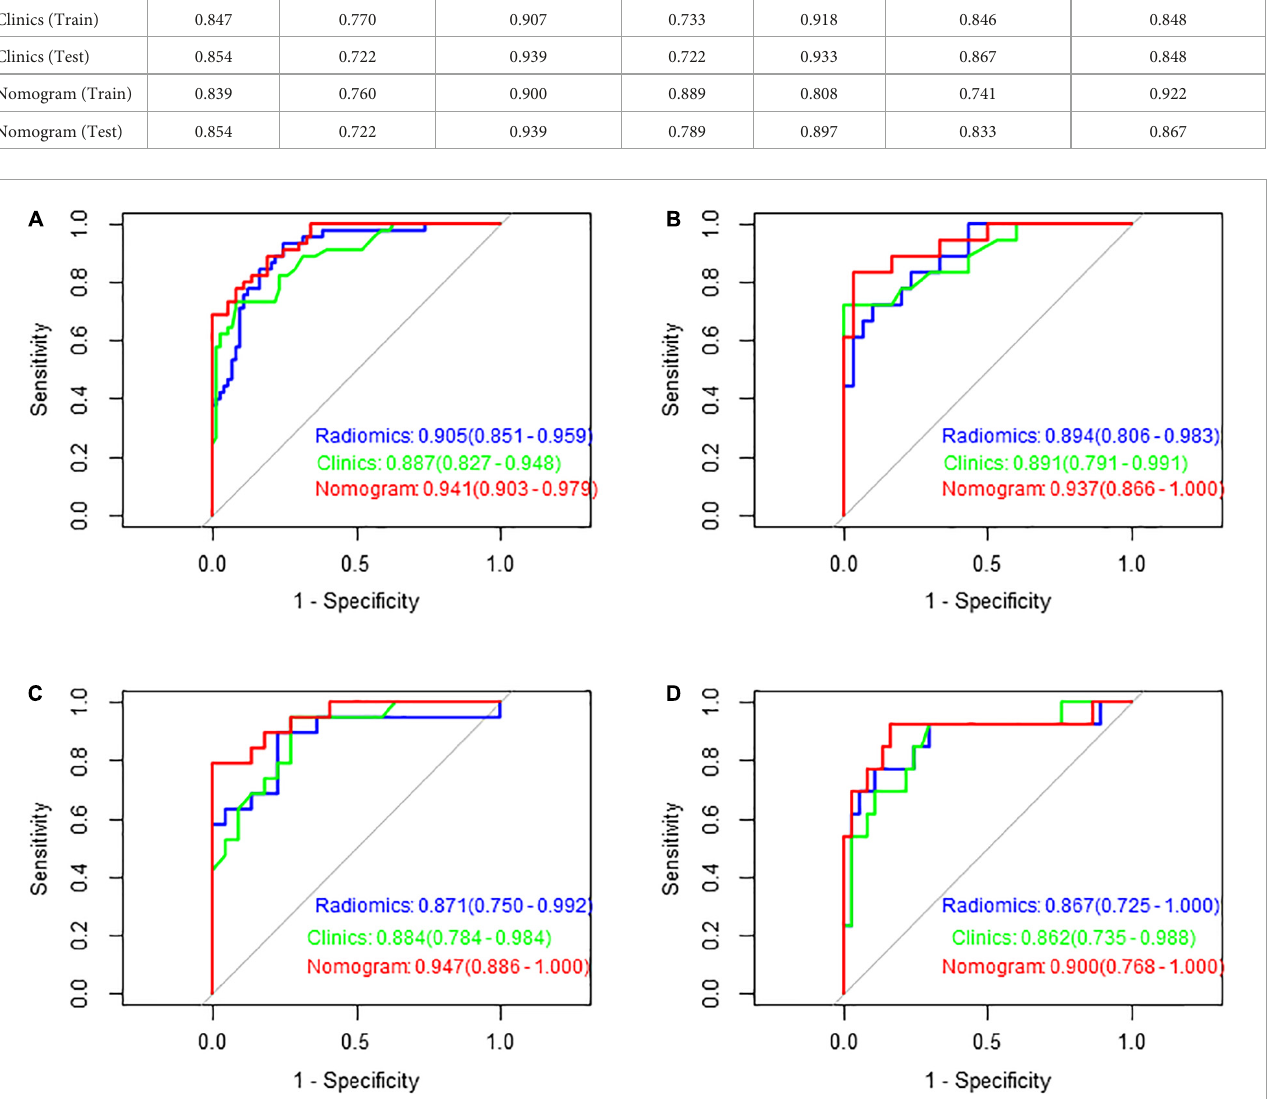
FIGURE7 Receiver operating characteristic (ROC) curves of the three models in predicting the clinical functional outcomes of ischaemic stroke in the training set (A) , test set (B) , validation set 1 (C) , and validation set 2 (D) .